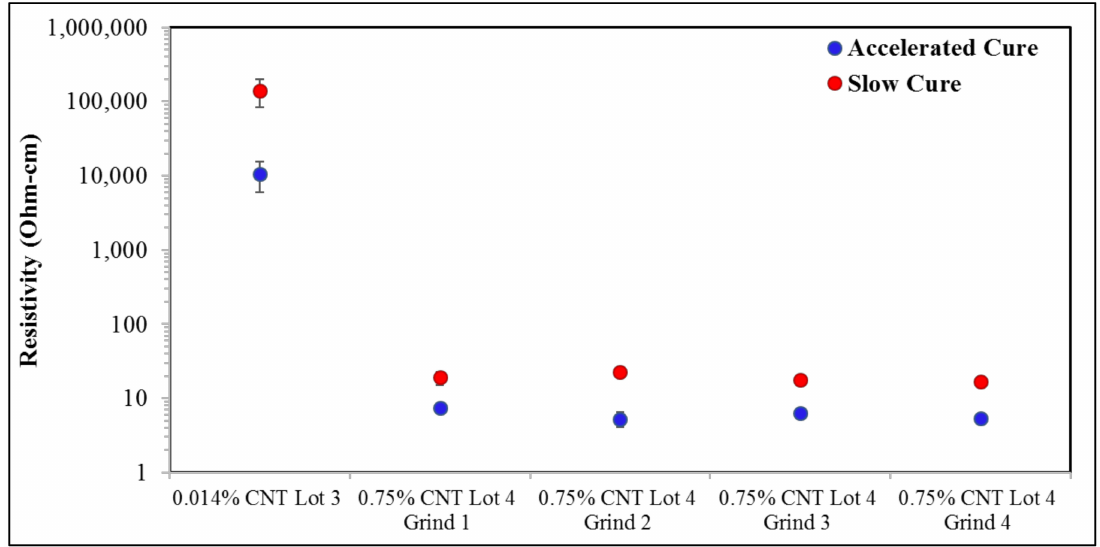
Figure 6. Impact of curing time/temperature on composite resistivity. All samples were measured at 5 µ